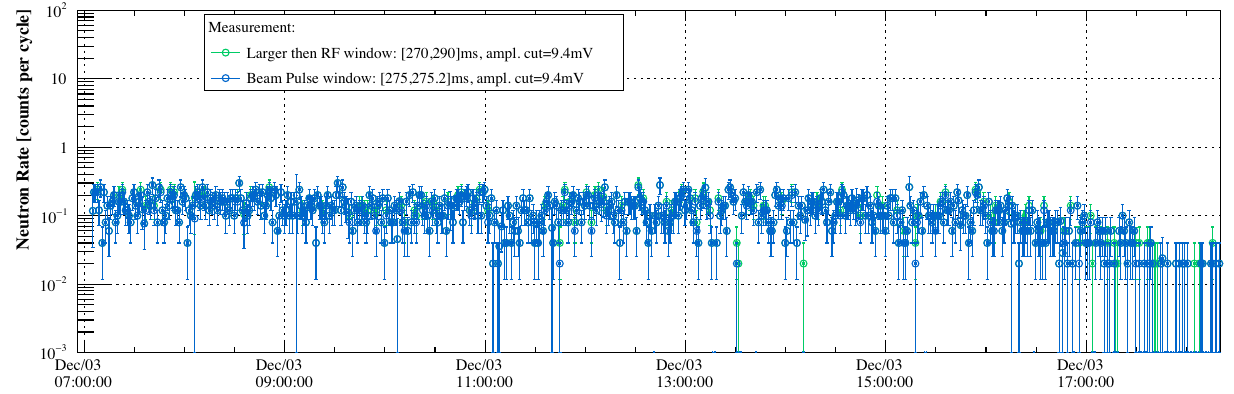
FIG. 18. Example of estimated neutron rates during a typical day with LINAC4 commissioning activities focused on sections further downstream of the nBLM